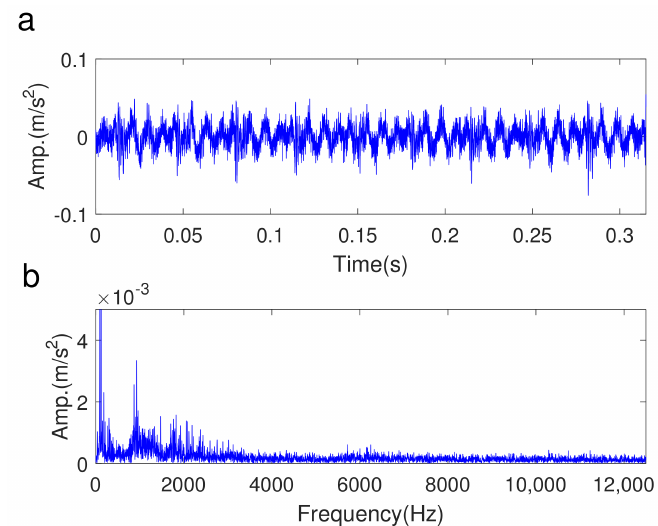
Figure 13. The original signal of the gear with a tooth root crack: ( a ) temporal waveform ( b ) the FFT